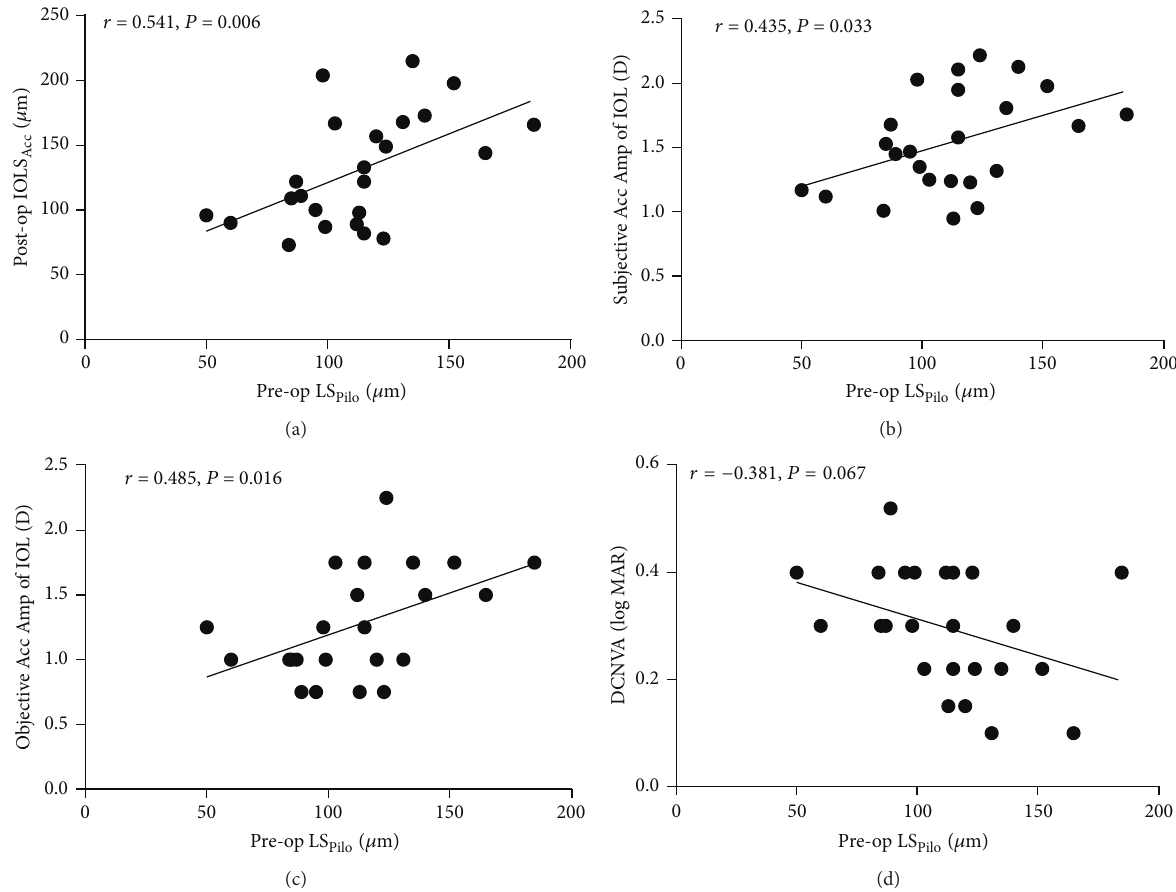
Figure 2: Correlation of preoperative lens shifts induced by pilocarpine (LS positively correlated with the postoperative intraocular lens shift under an accommodation stimulus (IOLS LS Pilo positively correlated with the postoperative subjective accommodation of Acc-IOLs ( 𝑟 = 0.435 ; 𝑃 = 0.033 ). (c) (b) The preoperative LS Pilo positively correlated with the postoperative objective accommodation of Acc-IOLs ( 𝑟 = 0.485 ; 𝑃 = 0.016 ). (d) The The preoperative LS Pilo did not correlate with the postoperative distance-corrected near visual acuities (DCNVA) (logMAR value) ( 𝑟 = 0.381 ; preoperative LS Pilo 𝑃 = 0.067